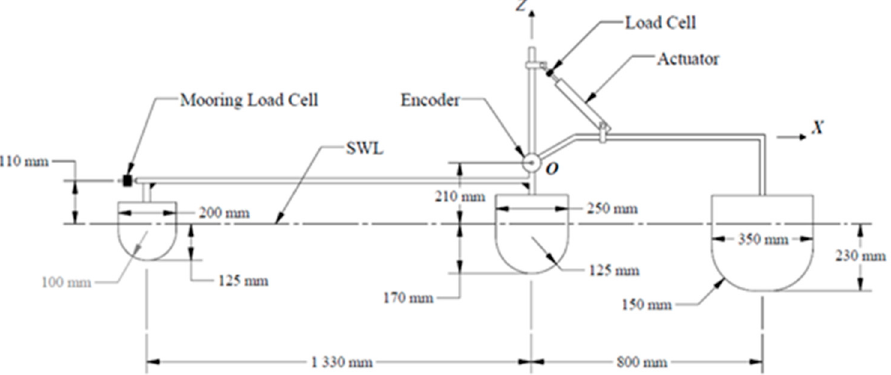
Figure 2. Elevation dimensions of physical model.